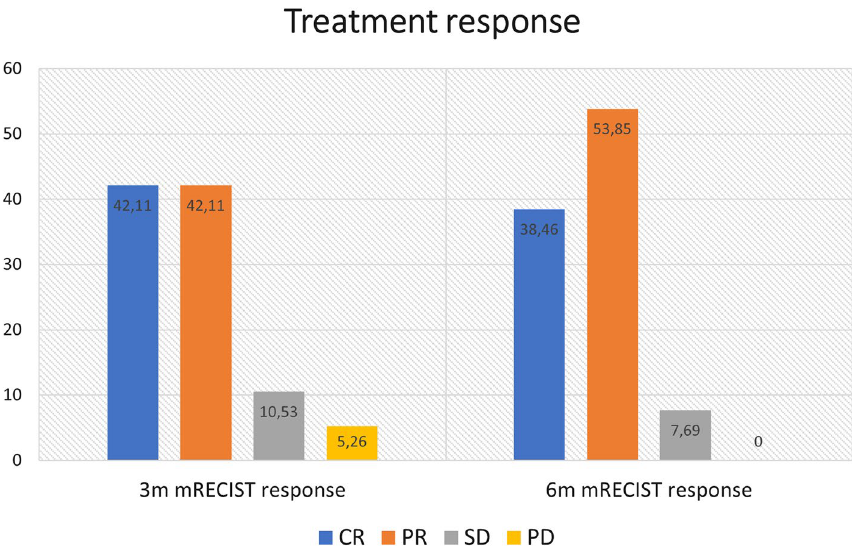
Fig. 2 Response stratification using mRECIST criteria at 3 and 6